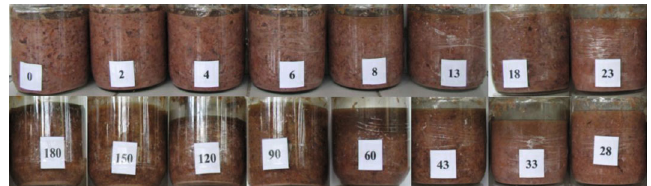
Figure 1: Observation of recipe A for 180 days of fermentation. The number showed the fermentation time,